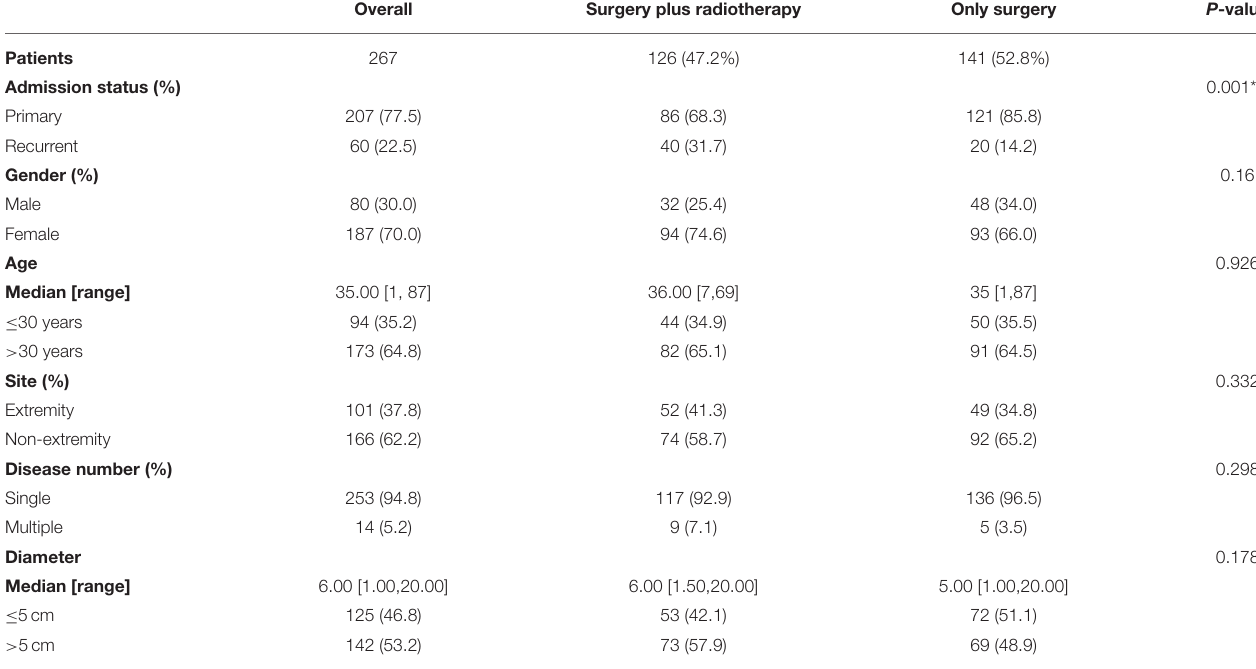
TABLE 1 | The patients demographics and tumor characteristics. Overall Surgery plus radiotherapy Only surgery P -value Patients